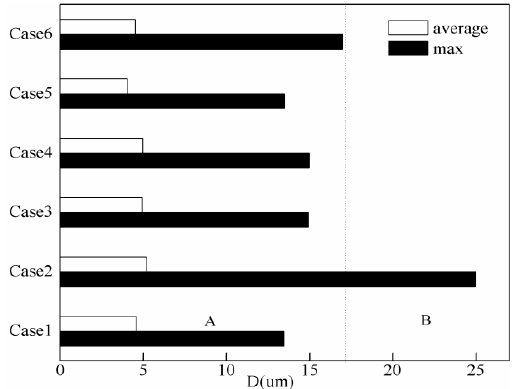
Figure 5. The maximum and average diameter during the formation stages of dense fog and strong dense fog.